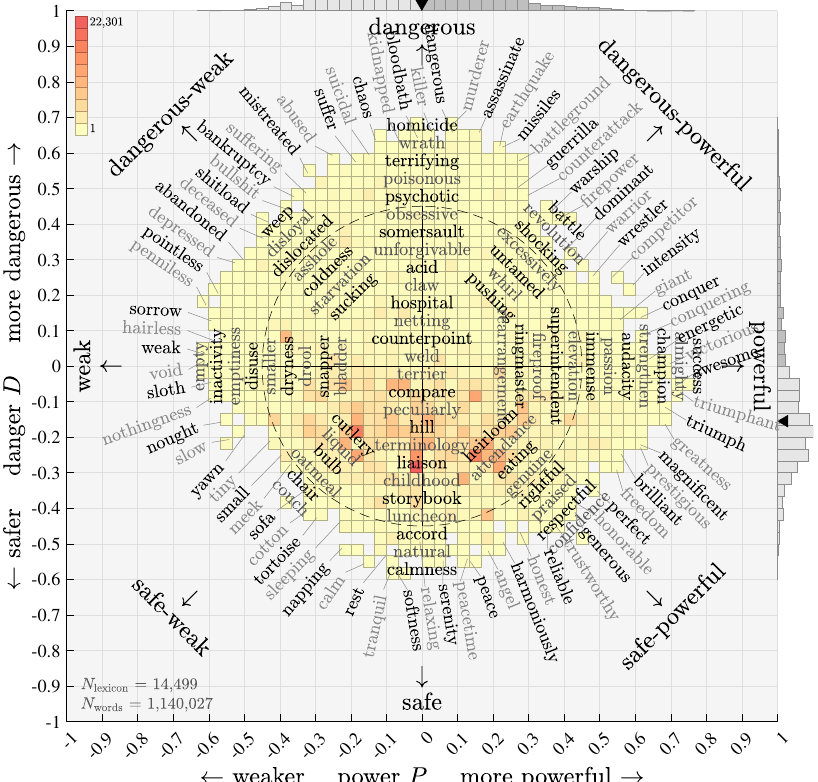
Fig. 1 An ‘ ousiogram ’ (Dodds et al., 2021) displaying power and danger scores for a subset of 14,499 unique words appearing in Terry Pratchett ’ s 41- book Discworld series. The example words overlaid map the indicated eight major directions of the compass of essential meaning. The full set of 20,006 words with power and danger scores is derived from the NRC VAD lexicon (Mohammad, 2018). These 14,499 unique words collectively account for 1,140,027 total words (types versus tokens). The histogram ’ s color map indicates the frequency of usage. The histogram, along with the marginal distributions for power and danger (right and top) presents the same safety bias observed across disparate corpora (Dodds et al.,